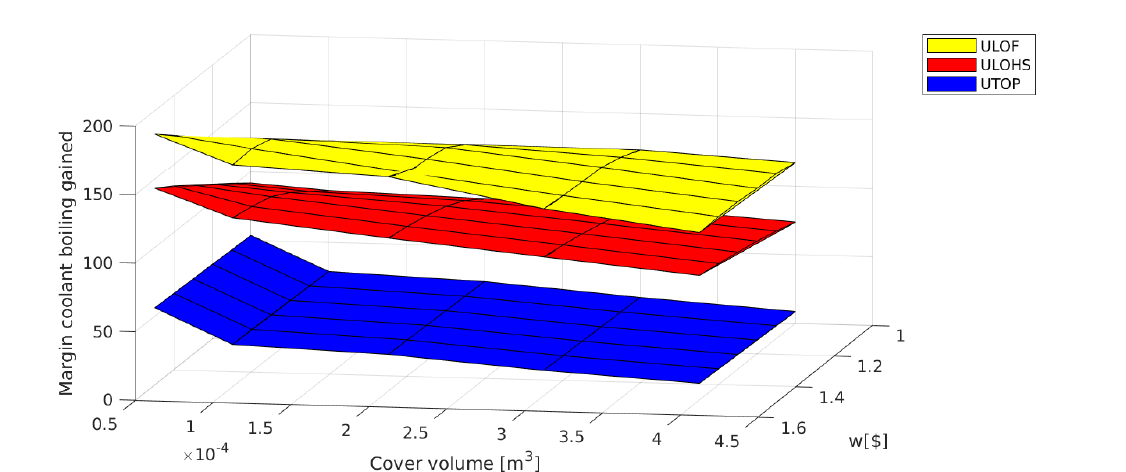
Figure 6: Coolant margin in ABR core with the enhanced ARC